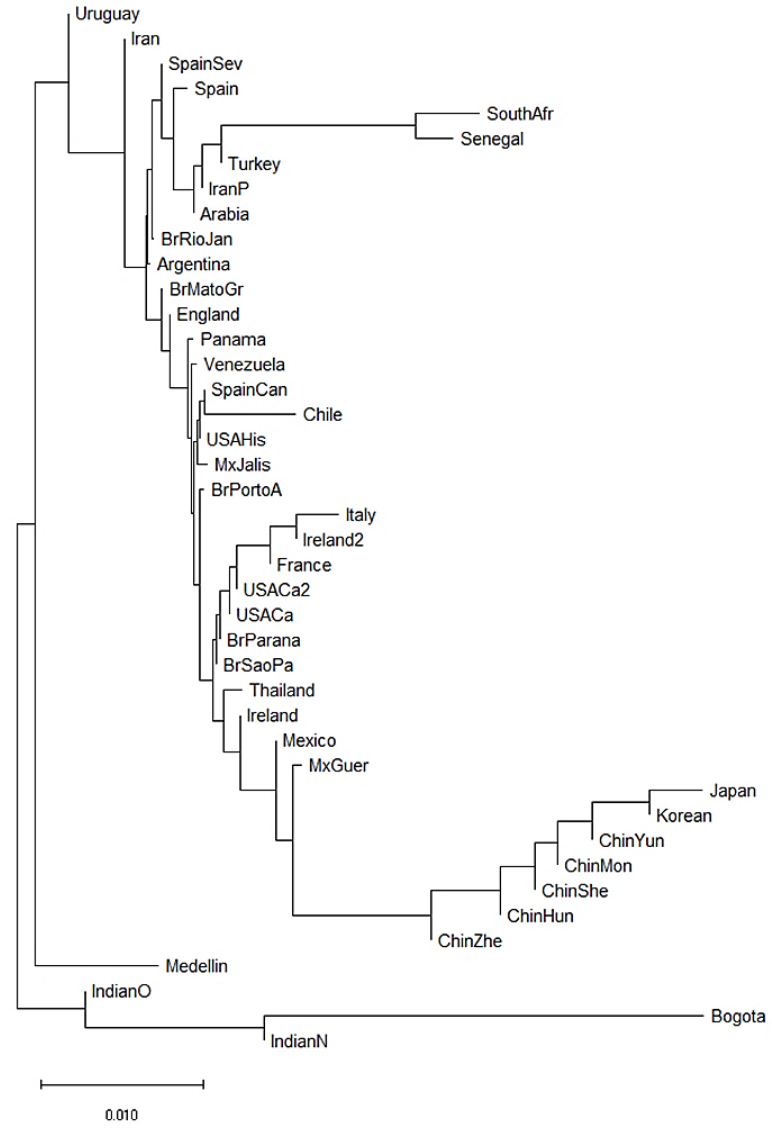
Figure 3. Neighbor-joining (NJ) dendrogram of Nei ´ s genetic distances among worldwide popula- tions, based on the KIR genes frequencies. The NJ dendrogram was constructed with 42 populations from China ( n = 1788), Brazil ( n = 1327), Spain ( n = 847), India ( n = 673), England ( n = 584), United States ( n = 578), Mexico ( n = 544), Iran ( n = 448), Ireland ( n = 440), Argentina ( n = 365), Thailand ( n = 235), Italy ( n = 237), Venezuela ( n = 205), South Africa ( n = 167), Arabia ( n = 162), South Korea ( n = 159), Turkey ( n = 154), Japan ( n = 132), Senegal ( n = 118), Panama ( n = 116), France ( n = 108), Chile ( n = 90), Uruguay ( n = 41), Bogota — Colombia ( n = 119) and Medellin — Colombia ( n = 161). The bar suggests a 0.01 (10%) KIR gene frequencies variation for the length of the scale.